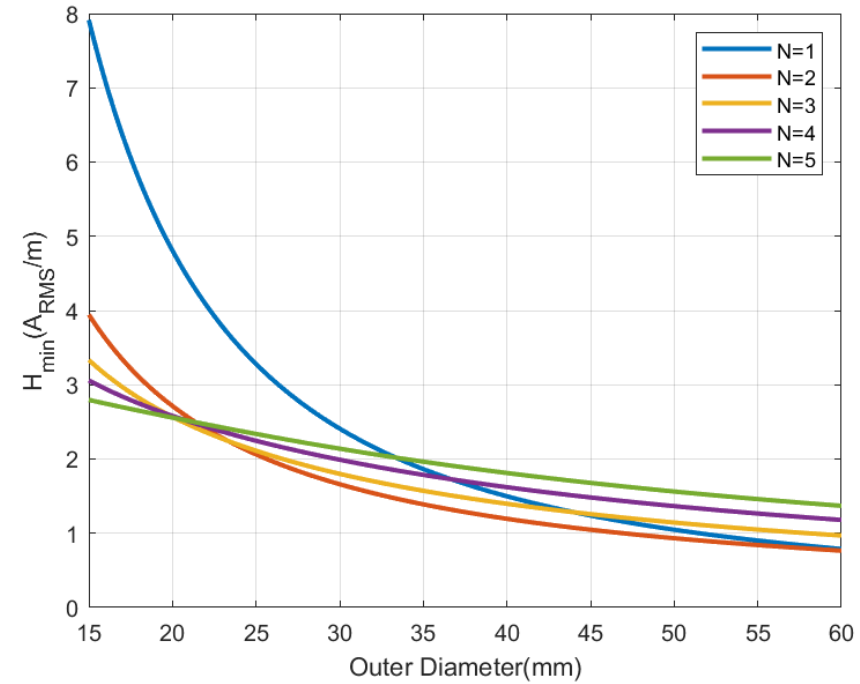
Figure 9. Simulated minimum magnetic field as a function of the outer diameter for a square antenna with a different number of turns.